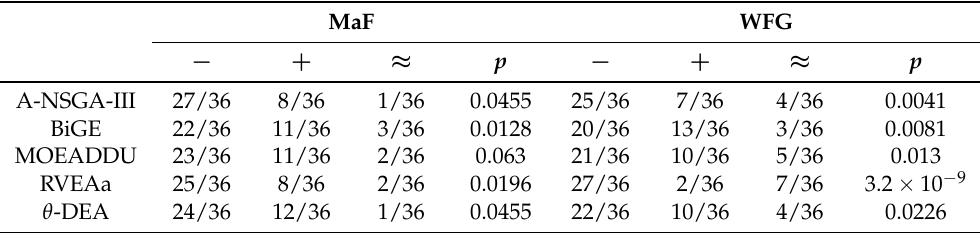
Table 3. Ratio of test cases where the corresponding baseline MaOEA performs worse than ( − ), better than ( + ), and similar to ( ≈ ) the proposed algorithm with respect to